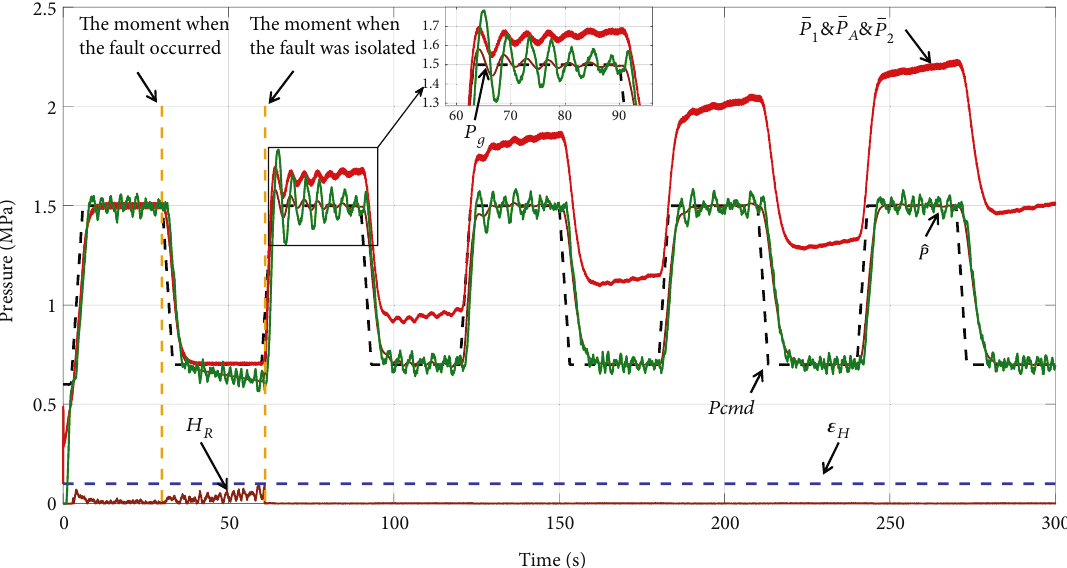
Figure 13: Both sensors fail with the same drift